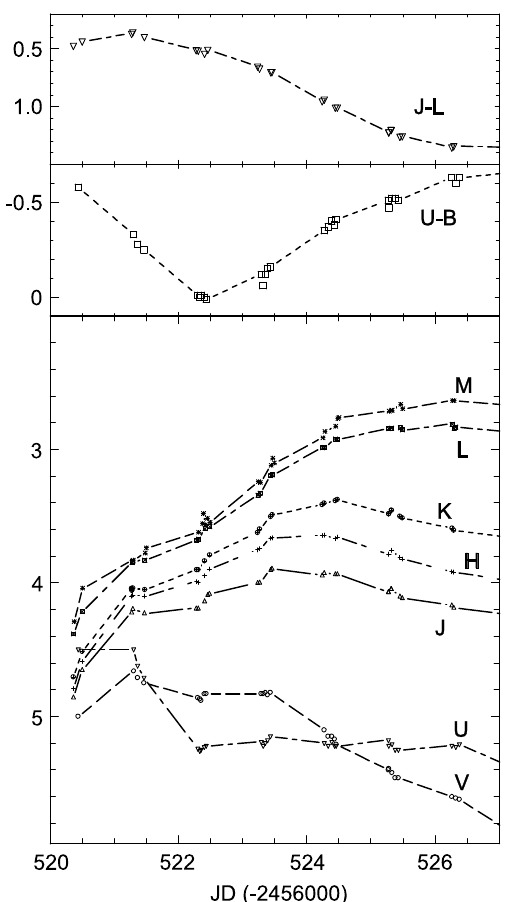
Fig. 2. The UVJHKLM light curves and U (cid:0) B color curve of Nova Delphini 2013 during the (cid:12)rst 7 days of our observations. The rate of decline puts Nova Del 2013 into the group of fast